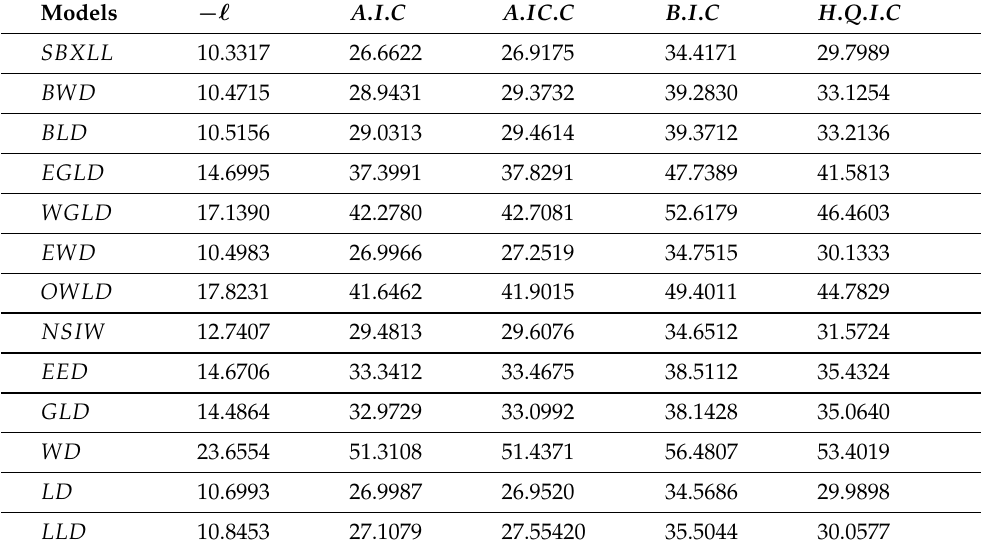
Table 18. Comparison of data set III fitting via information